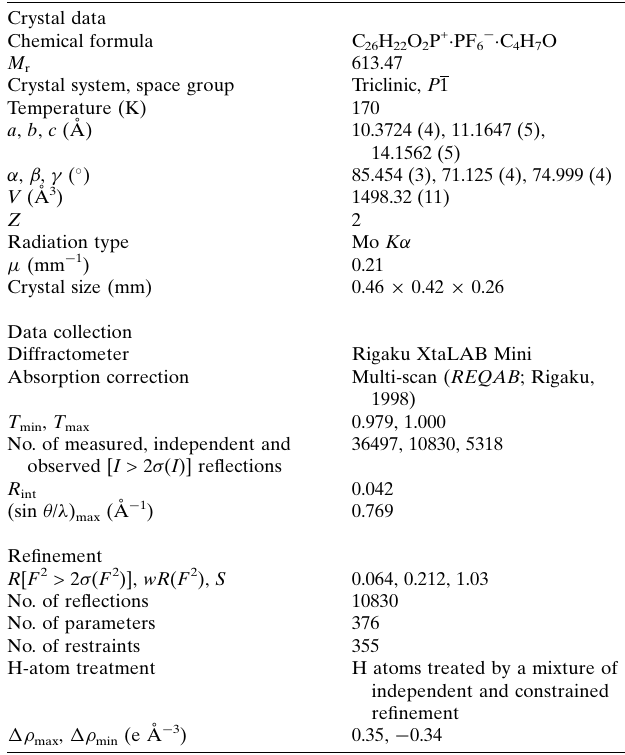
Table 2 Experimental details. Crystal data Chemical formula